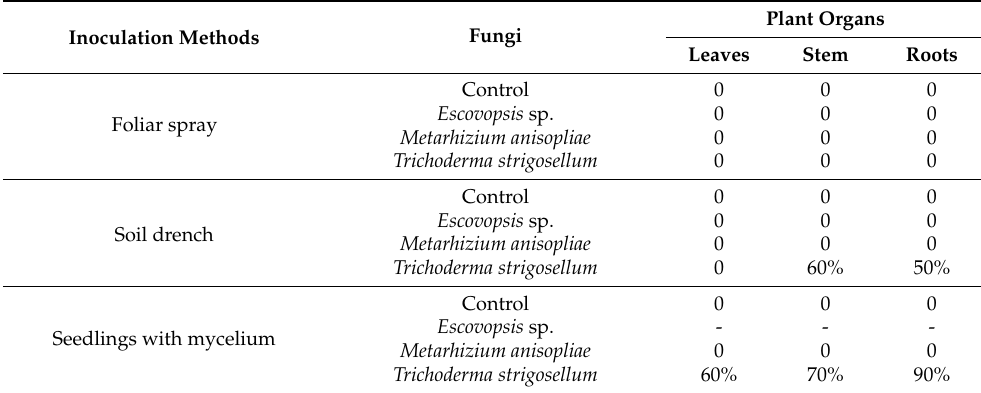
Table 1. Re-isolation of the fungal species ( Escovopsis sp., Metarhizium anisopliae , and Trichoderma strigosellum ) inoculated using three methods (foliar spray, soil drench, and seedlings with mycelium) in the leaves, stems, and roots of Eucalyptus urophylla ( n =